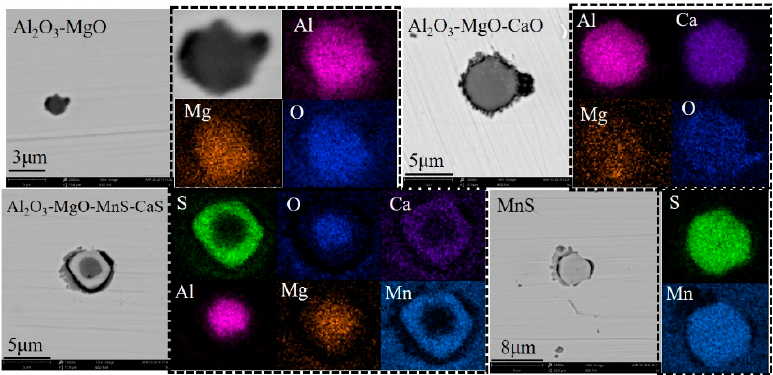
Figure 4. SEM images and energy-dispersive spectroscopy (EDS) maps of the typical inclusions in B1. B2 is the group B samples after heating. There are mainly two types of inclusions in the sample: Al 2 O 3 -MgO-CaS, CaS inclusions and a small number of MnS inclusions. The typical morphologies